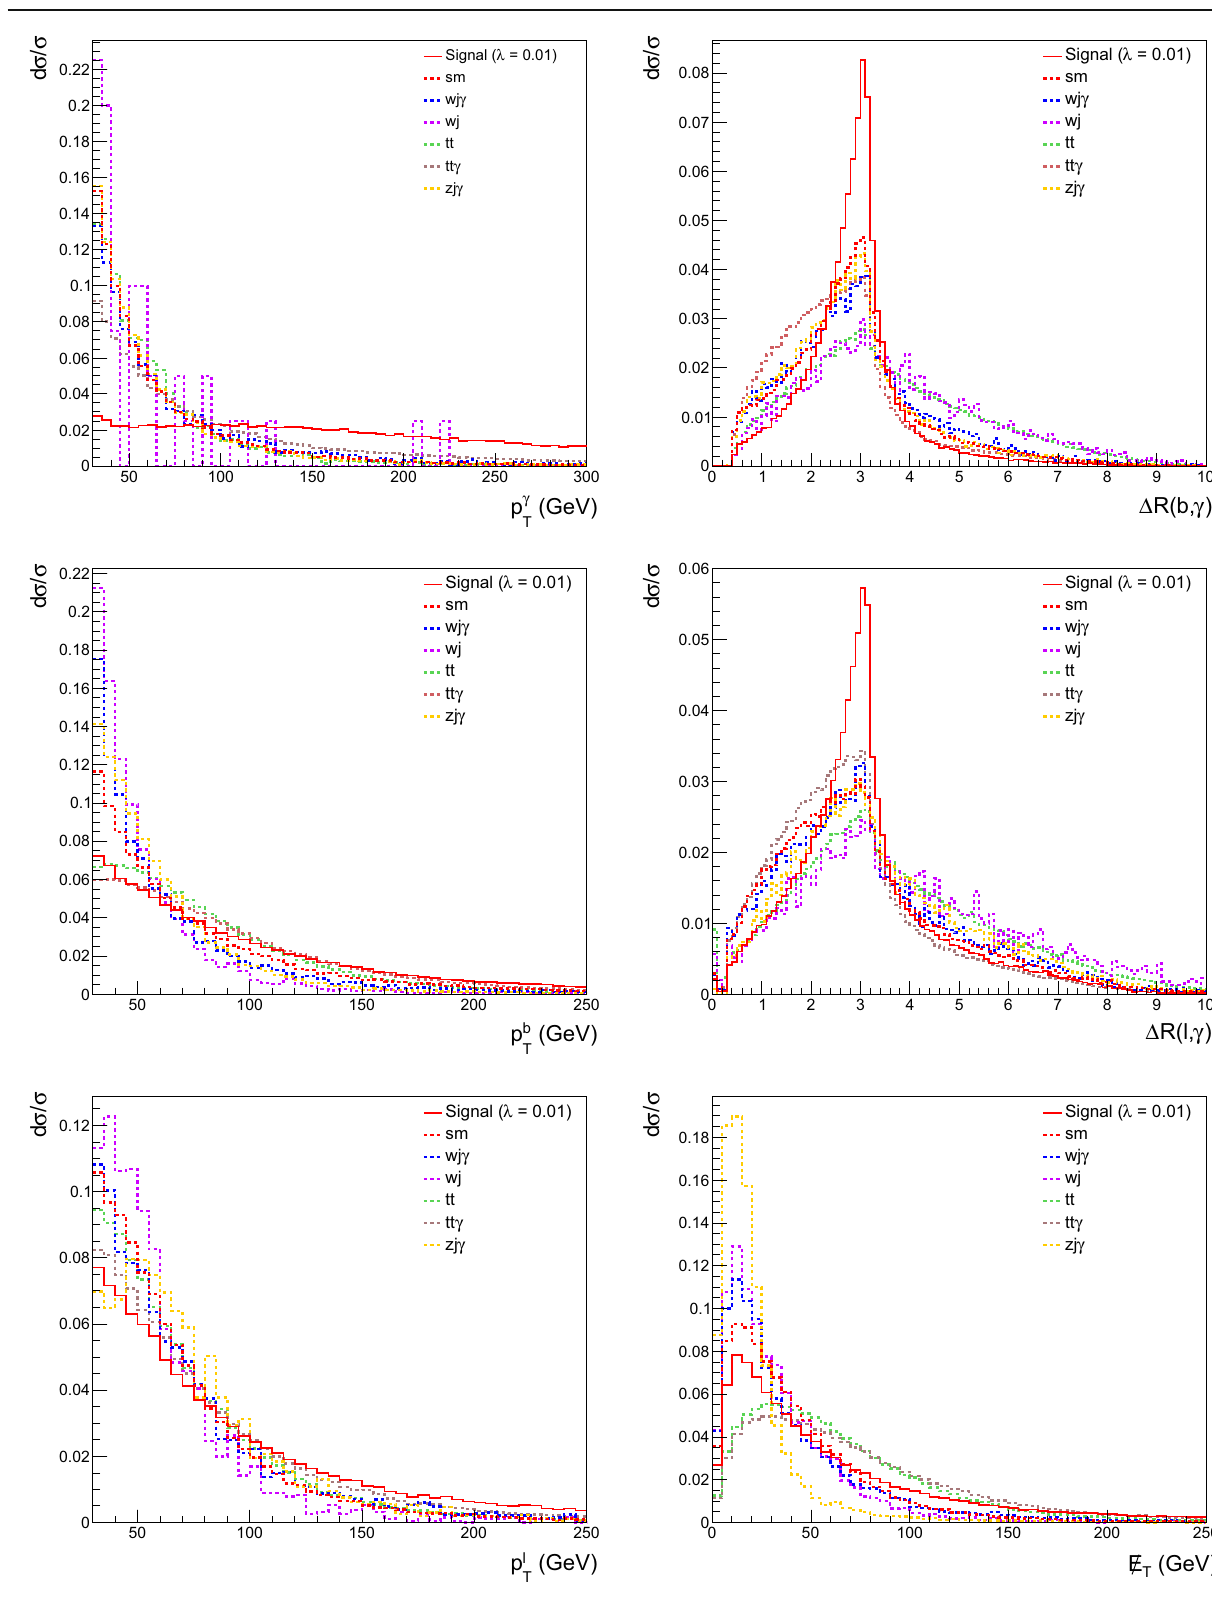
Fig. 3 The kinematic distributions of the final state particles in leptonic channel for signal ( λ q = 0 . 01) and relevant SM background processes; transverse momentum of γ , b -jet and lepton on the left column and (cid:8) R ( b ,γ) , (cid:8) R ( l ,γ) and MET on the right